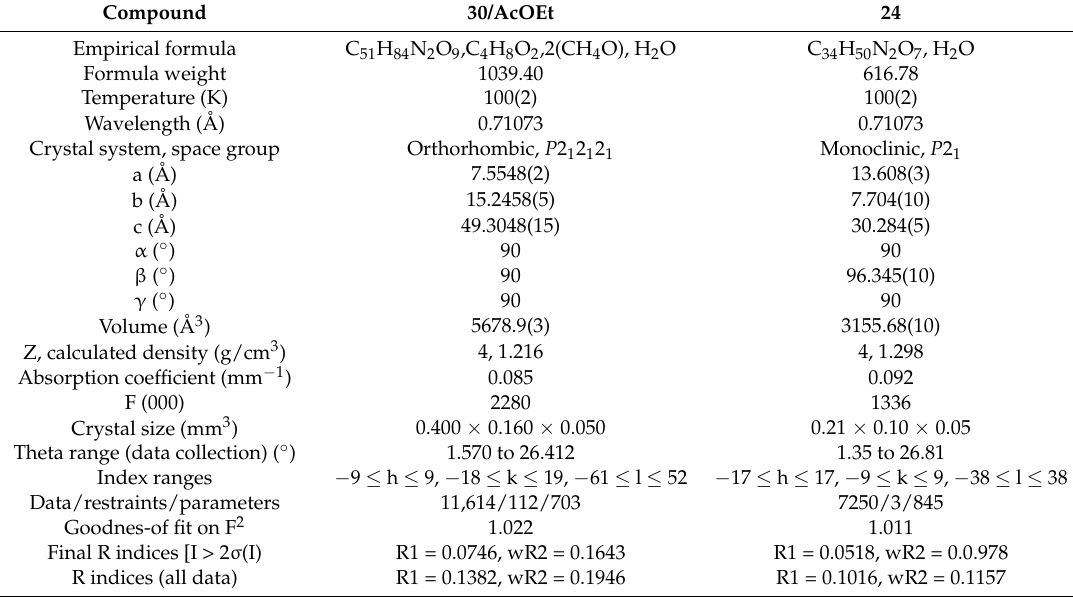
Table 3. Crystal data, data collection, and refinement for 30 recrystallized from AcOEt/MeOH and 24 recrystallized from